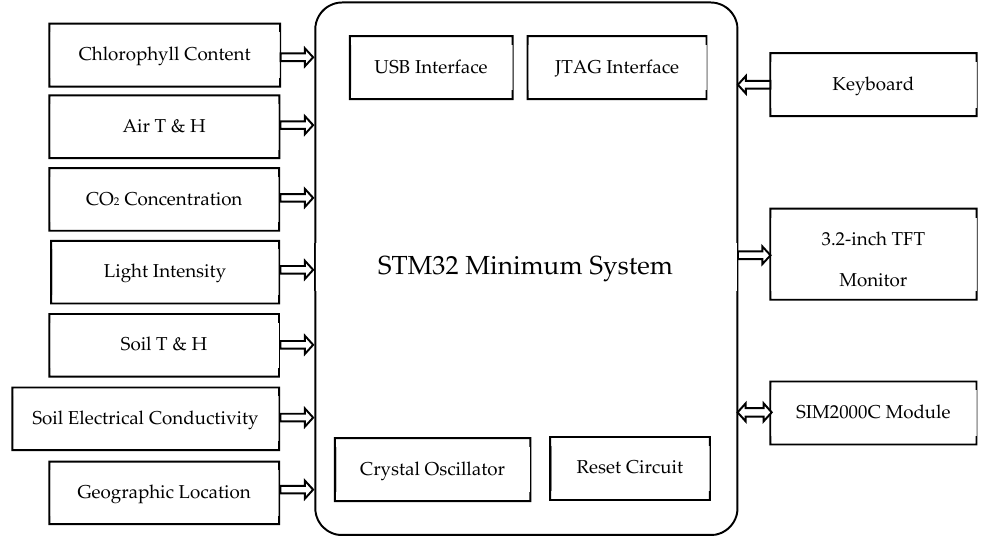
Figure 2. Block diagram of the farmland information collection device.